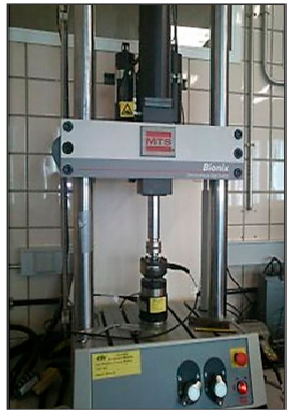
Figure 1. MTS Bionix 858 ® .